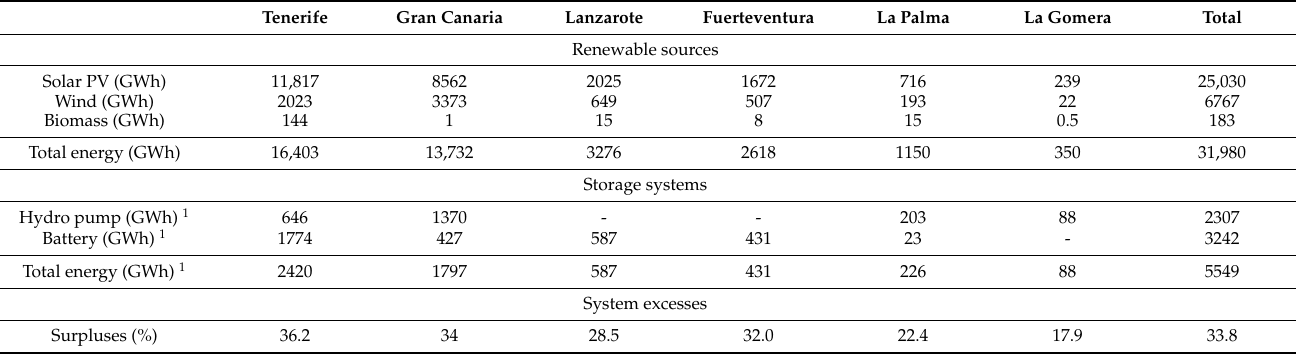
Table 8. Energy production per component and